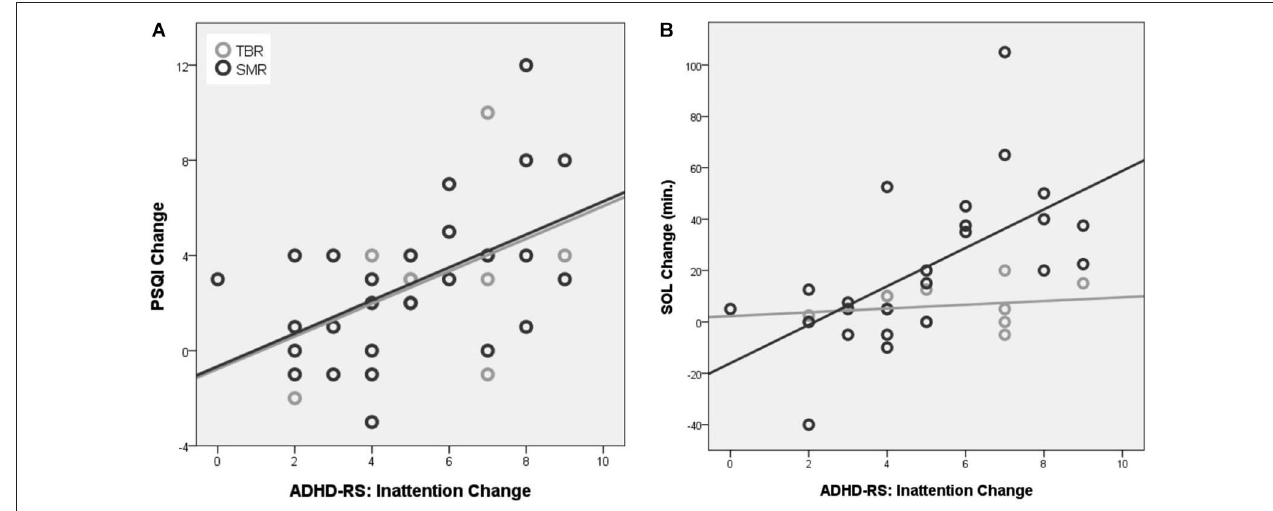
improvement on PSQI change and inattention and SOL and inattention was observed that explained 34% and 39% of the variance